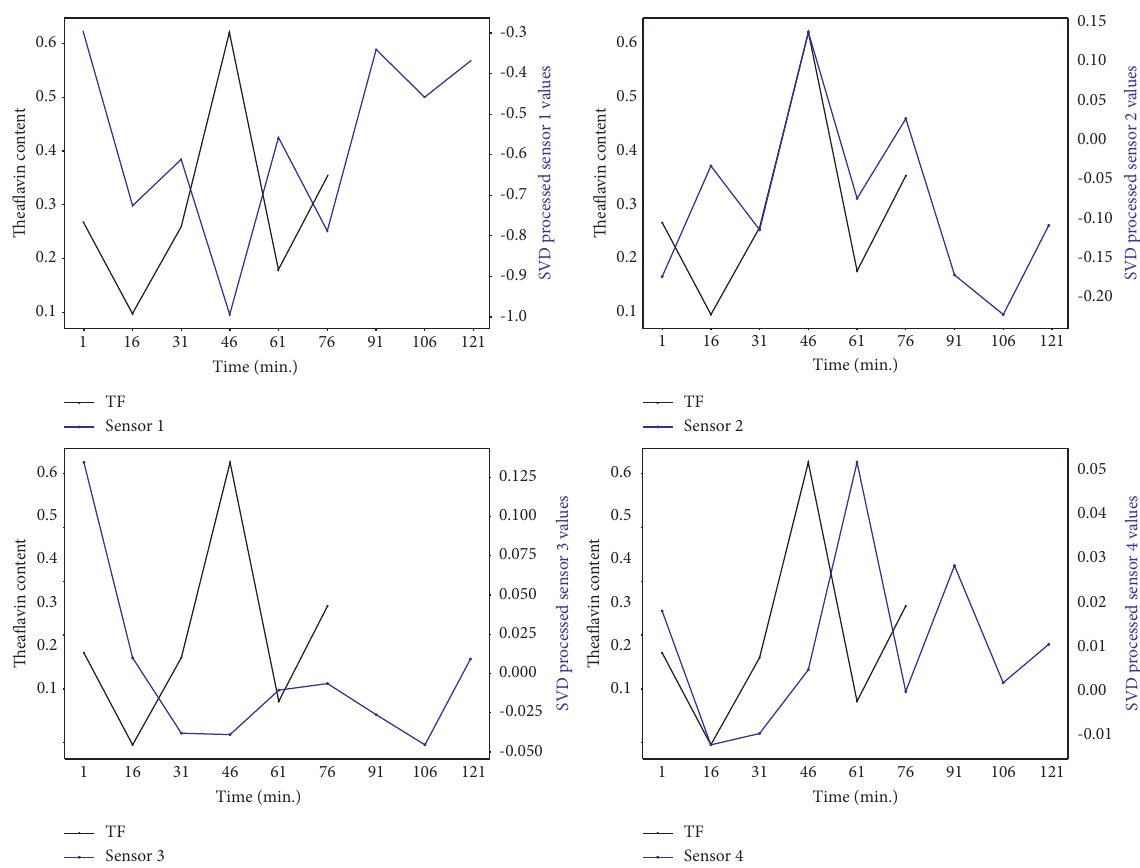
Figure 7: Comparison of variation of smell peaks detected by each sensor with TF content. Table 5: Comparison of time at maximum peak for Digi-Nose sensors and theaflavin. Peak Fermentation cycle